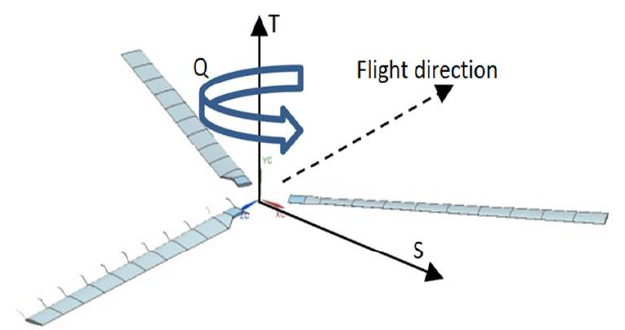
Fig. 6. Visualisation of the MBD main rotor base model